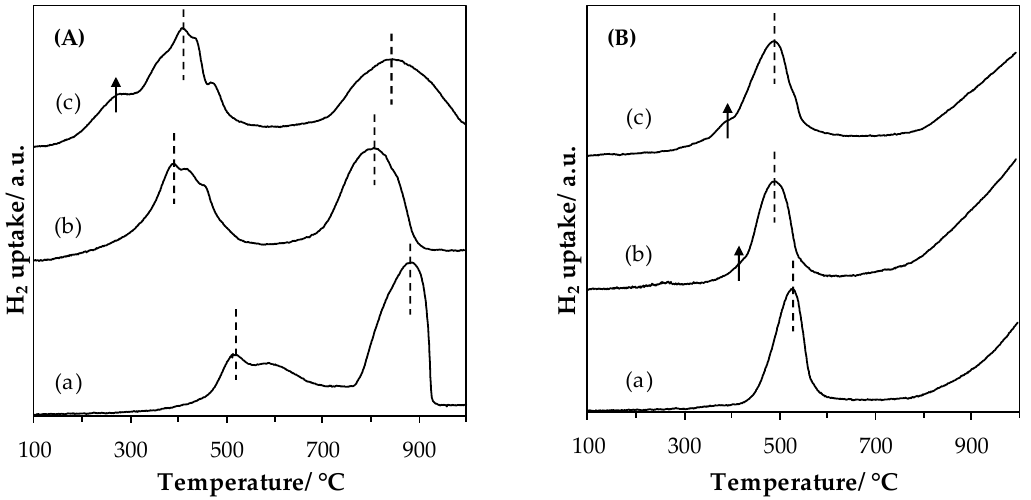
Figure 4. Temperature-programmed reduction (H 2 -TPR) profiles of LaMnO 3.15 ( A ) and LaFeO 3 ( B ) samples after the (a) SSR, solid state reaction; (b) HEBM, high-energy ball milling; (c) LEBM, low-energy ball milling, steps.